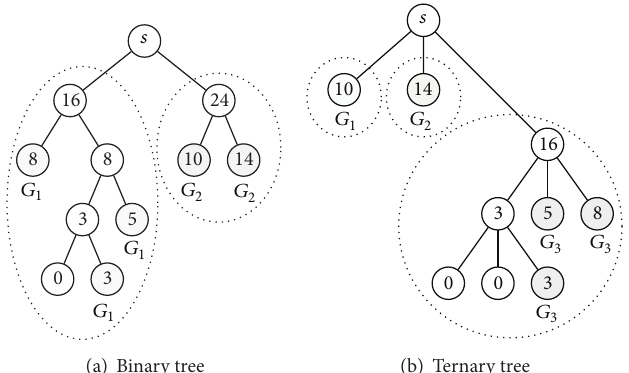
Figure 5: Example of binary and ternary Huffman trees . Labels 𝐺 𝑖 given beneath nodes indicate to which group a given peer should belong. The dotted circles indicate group borders. The values in circles denote 𝑝(𝑖) .